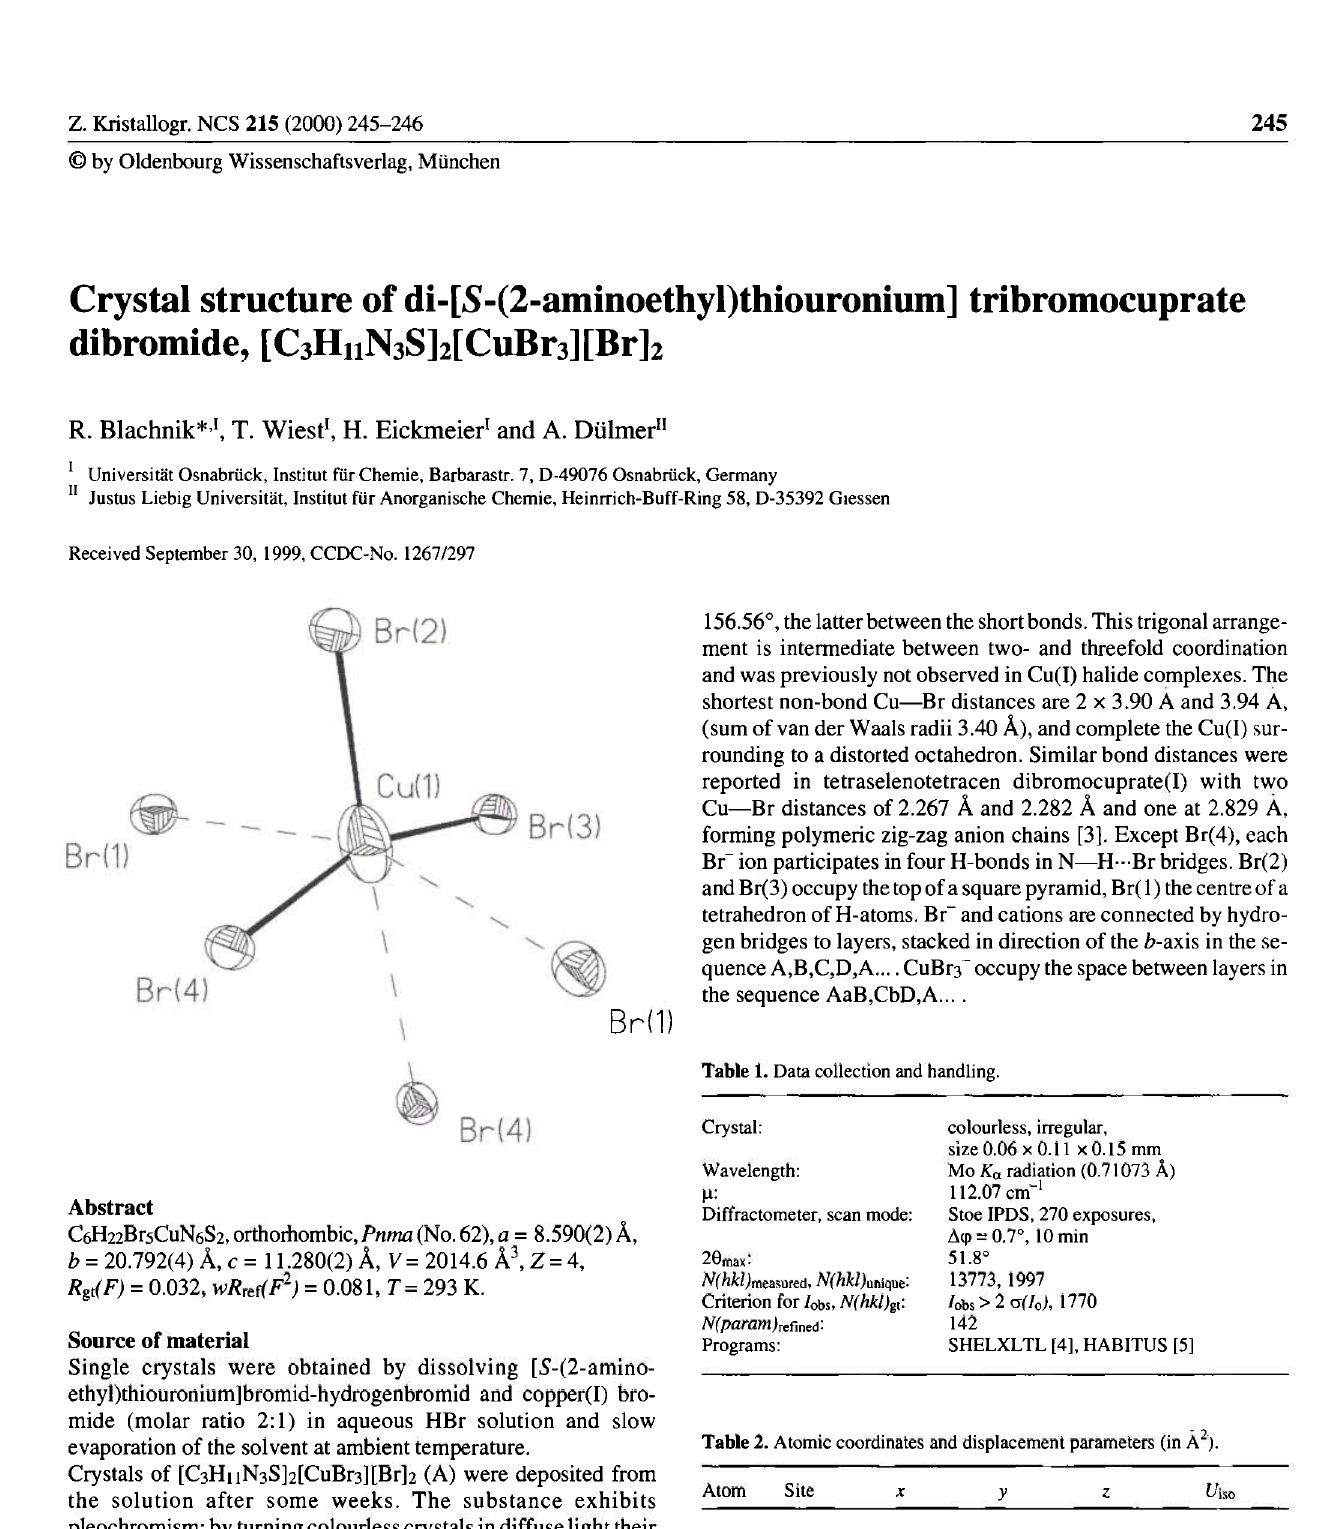
Table 2. Atomic coordinates and displacement parameters (in A 2